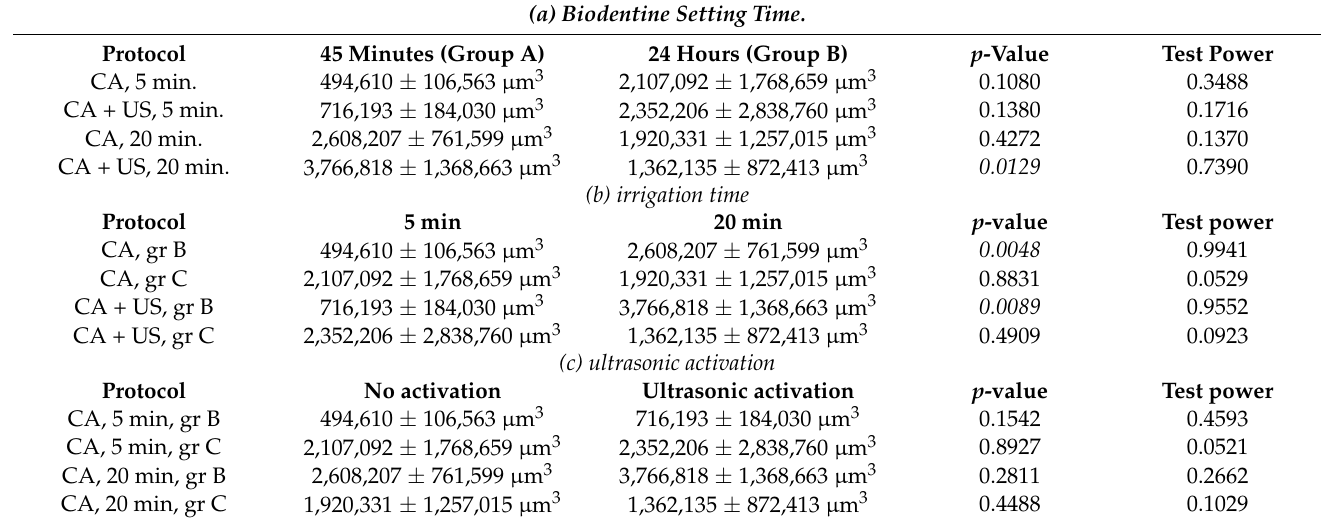
Figure 6. Statistical analysis: Biodentine volume loss depending on material setting time (45 min and 24 h), CA irrigation time (5 and 20 min) with and without its ultrasonic activation. Asterisks above graph indicate level of statistical significance * p < 0.05, ** p < 0.01. Table 4. Statistical analysis—material volume loss depending on ( a ) Biodentine setting time, ( b ) CA irrigation time, ( c ) ultrasonic activation of CA. (a) Biodentine Setting Time.